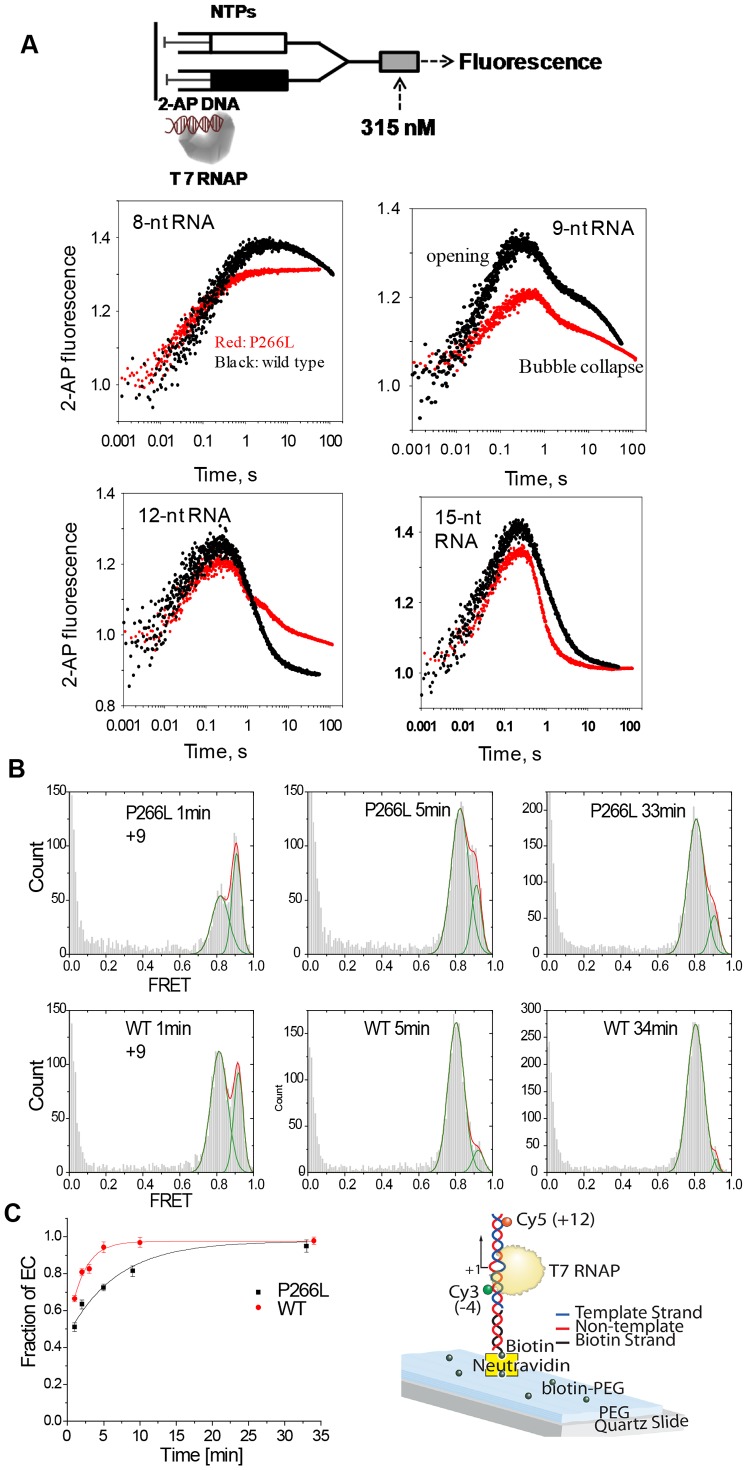
Upstream bubble collapse and transition into elongation are delayed in the P266L mutant.(A) Real time 2AP fluorescence monitors upstream bubble collapse. Representative time courses of 2-AP fluorescence changes from position −4NT in individual walking experiments (+8, +9, +12, and +15) were observed in the stopped-flow setup. The initial increase indicates rapid opening of the promoter and the decrease indicates bubble collapse. (B) Single molecule FRET histograms measure the rate of promoter unbending by WT and P266L T7 RNAP at +9. The number of DNA molecules that were analyzed to draw the smFRET histograms are as follows: P266L: 3110 at 1 min; 4164 at 5 min; 4883 at 33 min. WT: 3444 at 1 min; 3432 at 5 min; 5855 at 34 min. The x-axis shows corrected FRET (equation 2) and the y-axis represents the frequency of transcription complexes with the respective FRET values. Low FRET is observed in the elongation complex (EC) and high FRET is observed in the initiation complexes (IC). An increase in the low FRET population is observed over time after stalling at +9 using GTP+ATP+CTP+3′dUTP. Concentration of T7 RNAP-DNA, GTP, and NTPs was 10 nM, 1 mM, and 500 µM, respectively. (C) The fraction of EC versus time was fit to a single exponential function. The error bars in Fig 5C is the standard error from fitting smFRET histogram to a single exponential function. The WT (red circles) transitions to EC faster than P266L (black circles) at position +9 (τ = 4.5±1 min for P266L and 1.7±0.3 min for WT). The cartoon shows the layout of the smFRET experiments.